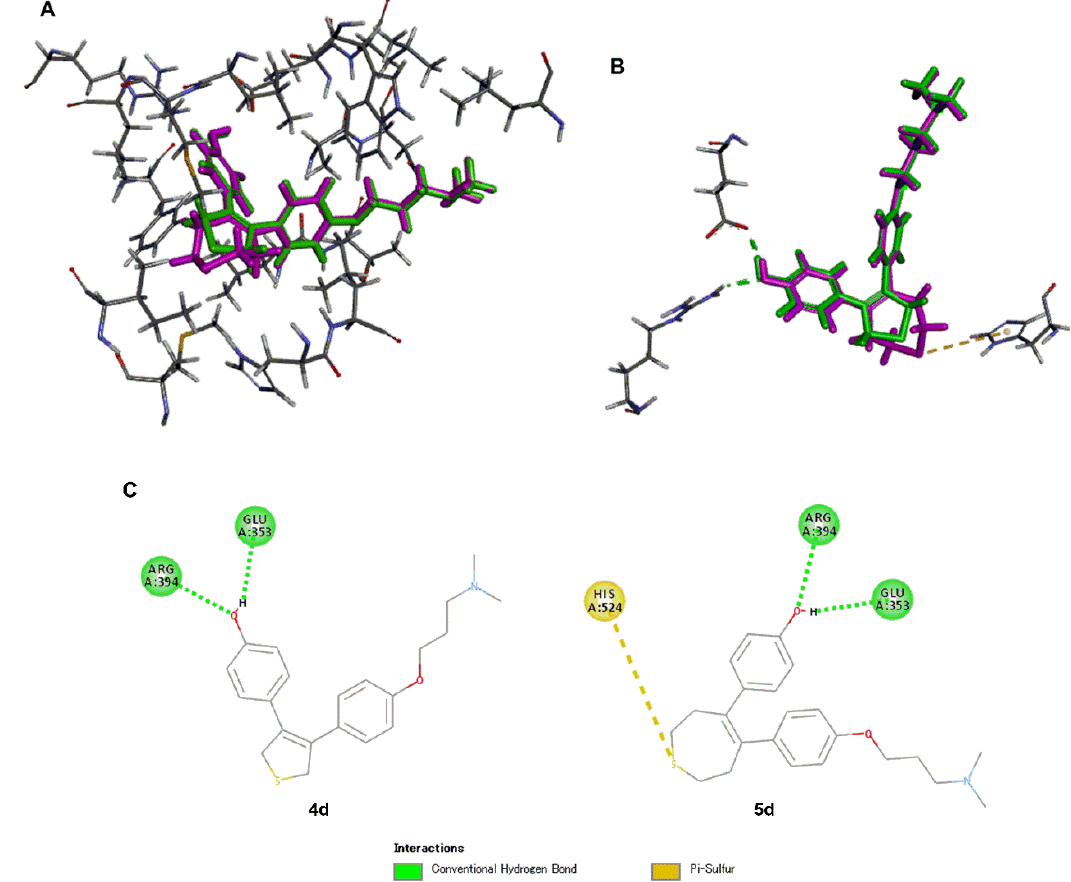
Figure 3. Docking modes of compounds 4d and 5d at the ER α ligand-binding domain (LBD). ( A ) Superimposed models of compounds 4d and 5d ; ( B ) Interaction modes of compounds 4d and 5d with the amino acid residues of the ER α LBD; ( C ) A sulfur– π interaction of 5d with the amino acid residue His524 of the ER α LBD.